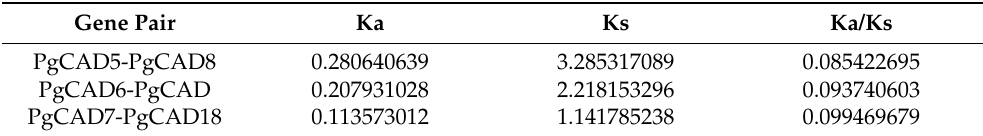
Figure 2. Chromosomal distribution of PgCAD genes. Chromosome numbers are shown next to each chromosome, and tandem duplicated genes are highlighted in red. The color bands on the chromosomes indicate gene density, with red indicating high gene density and blue indicating low gene density. The red line indicates three pairs of paralogous genes: PgCAD5 and PgCAD8 , PgCAD6 and PgCAD9 , PgCAD7 and PgCAD18 . Table 2. Estimated divergence period of the PgCAD gene pairs. Ks, synonymous substitution rate; Ka, non-synonymous substitution rate.